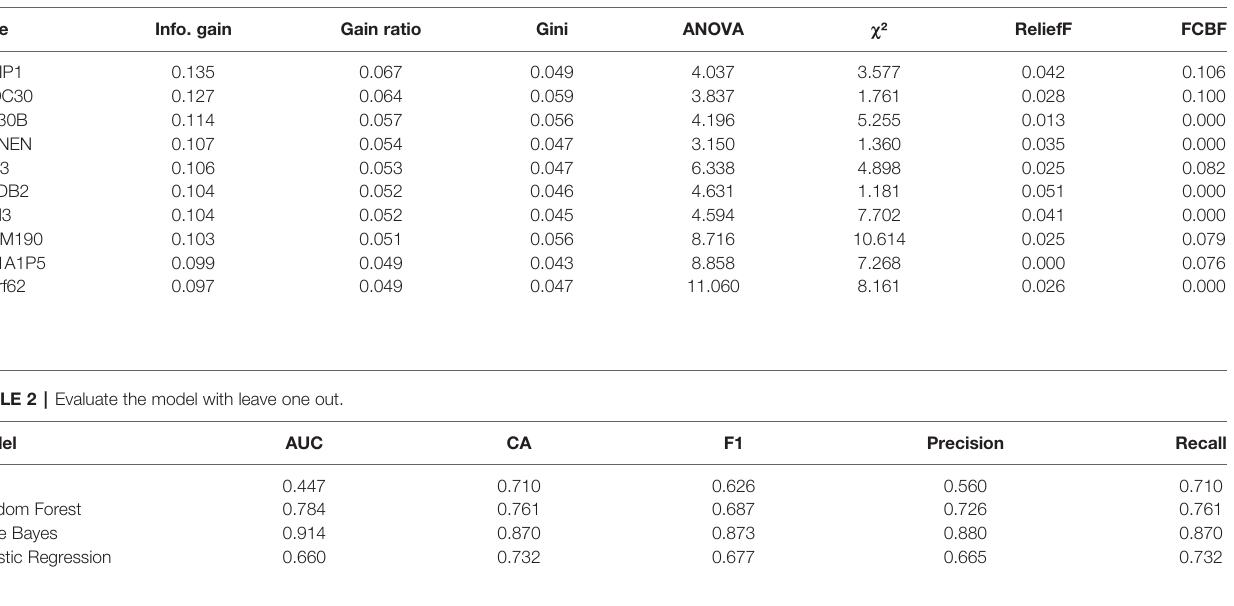
TABLE 1 | Feature gene extraction.